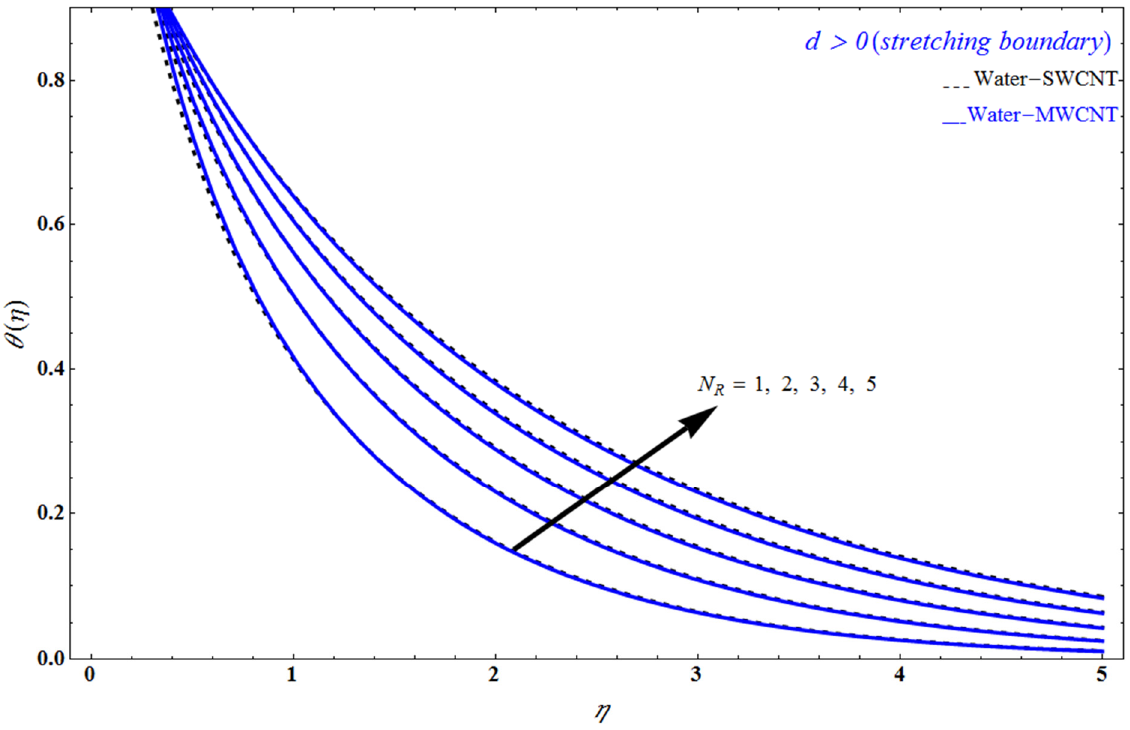
Figure 6. Effect of temperature profile θ ( η ) versus similarity variable η for several values of M , respectively.